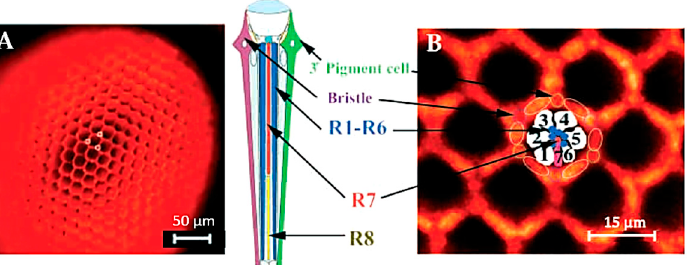
Figure 7. ( A ) Ommatidia of Drosophila eye imaged by epi-fluorescence under illumination with the green light. Under these observation conditions, the ordered honeycomb-like structure of the eye can be easily appreciated along with the accessory pigment cells. ( B ) Higher magnification shows the different cells composing an ommatidium pigment cells and lens facet, interpreted according to [92]. R1–R8, photoreceptor neurons. Modified from [91].